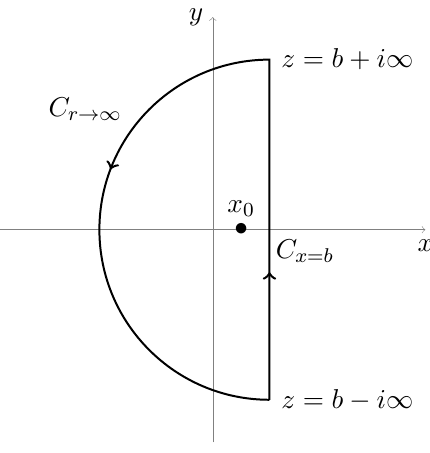
Figure 2 . Contour used for inverting the Laplace